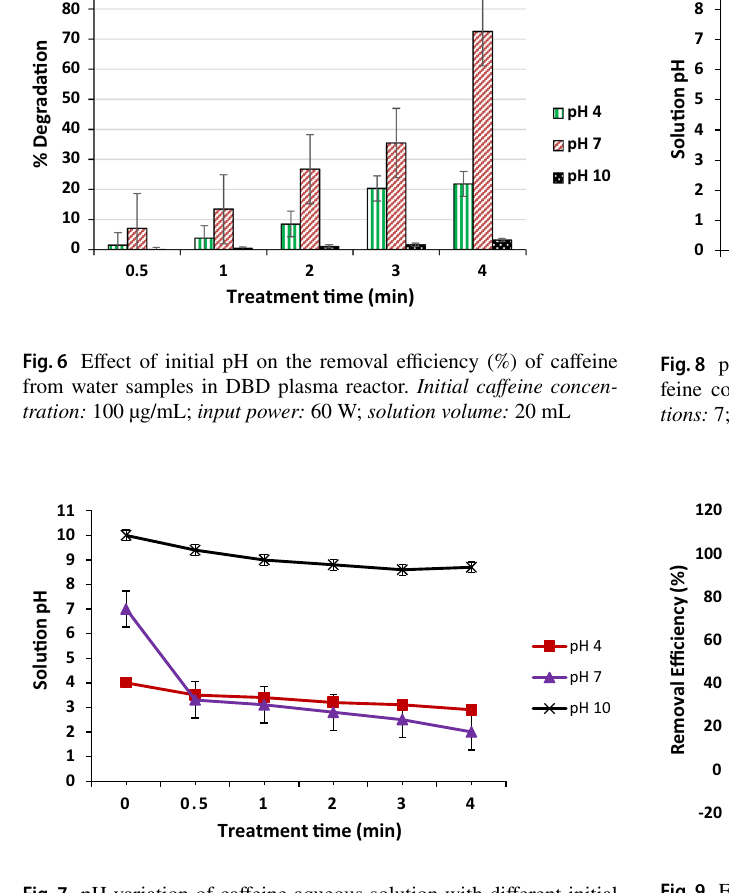
Fig. 7 pH variation of caffeine aqueous solution with different initial pH on DBD plasma treatment. Initial caffeine concentration: 100 µg/ mL; volume of sample: 20 mL and input power: 60 W